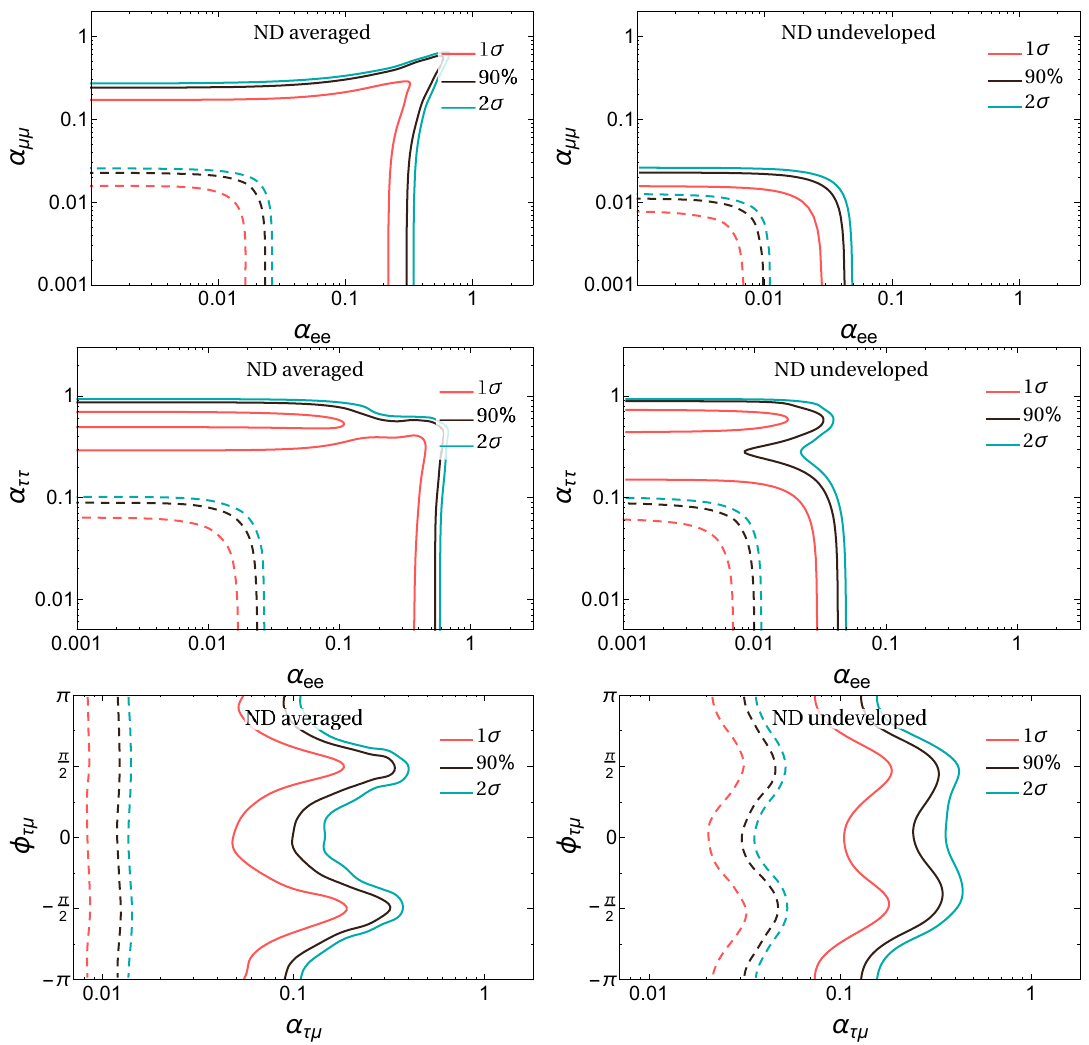
Figure 1 . Expected frequentist allowed regions at the 1 (cid:27) , 90% and 2 (cid:27) C.L. for DUNE. All new physics parameters are assumed to be zero so as to obtain the expected sensitivities. The left panels (ND averaged) correspond to the non-unitarity case, or to the sterile case when the light- heavy oscillations are averaged out in the near and far detectors. The right panels (ND undeveloped) give the sensitivity for the sterile case when the light-heavy oscillations have not yet developed in the near detector, but are averaged out in the far. The solid lines correspond to the analysis of DUNE data alone, while the dashed lines include the present constraints on sterile neutrino mixing from the middle and right columns in table 1 for the NS averaged and ND undeveloped scenarios